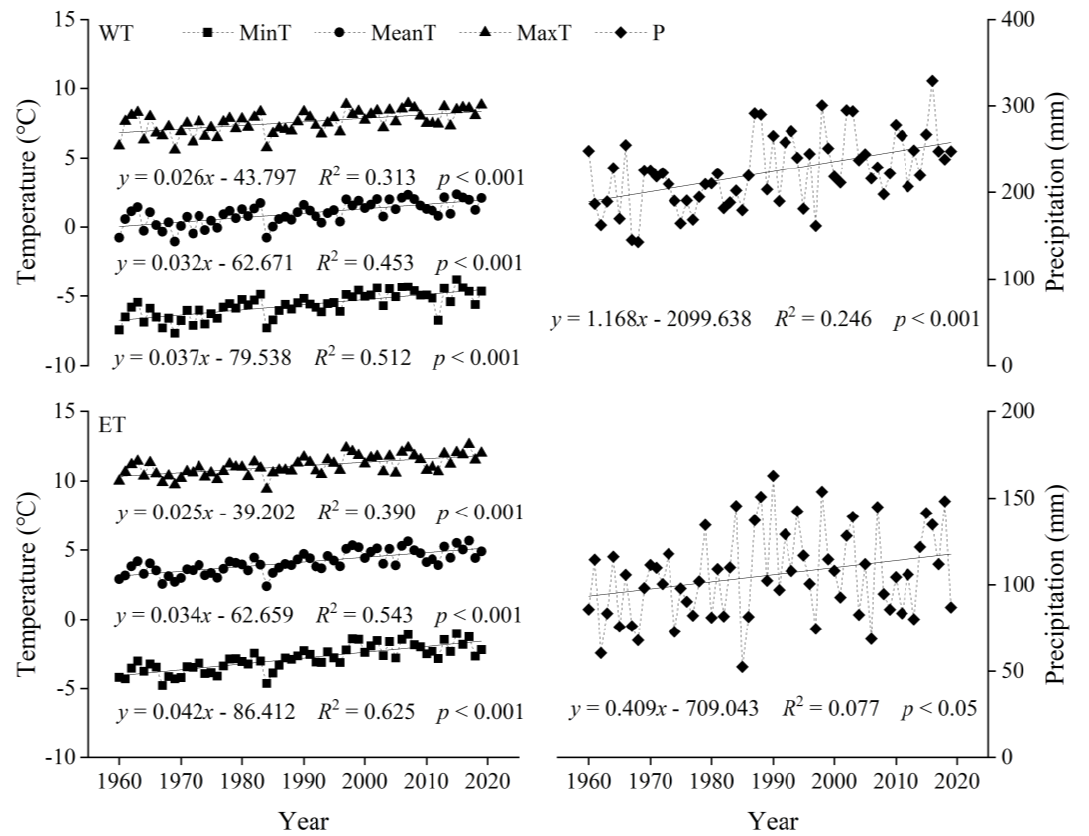
Figure 2. The monthly mean minimum (MinT), mean (MeanT) and mean maximum (MaxT) tem- peratures and monthly precipitation (P) during 1960 – 2019.